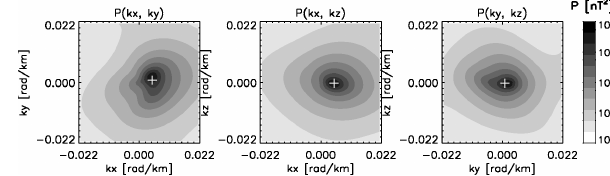
Figure 3: Example of a reduced three-dimensional power spectrum from the second interval Fig. 3. Example of a reduced three-dimensional power spectrum (5:31-5:41 UT) at ! sc = 3 : 44 rad/s. The white crosses indicate the maximum of the power spectrum. from the second interval (05:31–05:41UT) at ω sc = 3 . 44rads − 1 . The white crosses indicate the maximum of the power spectrum.